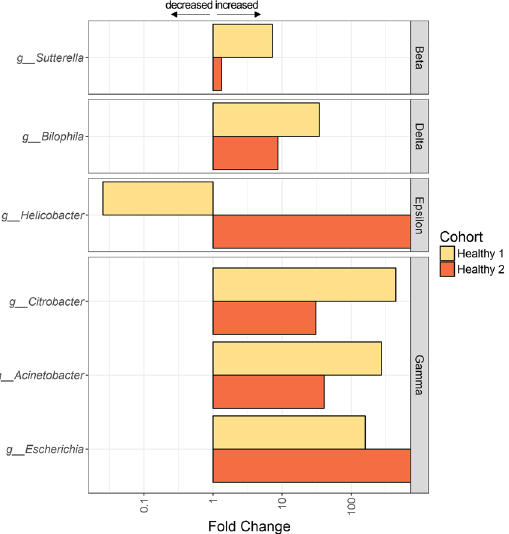
Figure 4. Significant increase of taxa from the Proteobacteria phylum in hospitalized patients. Fold change in taxonomic abundance of the Israel hospitalized cohort, relative to healthy Israeli population (Israeli health 1 & 2) is shown. A fold change greater than one represents an increase in hospitalized Israeli patients, and lower than one a decrease in hospitalized Israeli patients, compared to the other cohorts. Results are shown for significant taxa as inferred by a MaAsLin analysis (see methods), at the genus (g) level for the Betaproteobacteria (Beta), Deltaproteobacteria (Delta), Epsilonproteobacteria (Epsilon), and Gammaproteobacteria (Gamma) classes. Full data can be found in Table